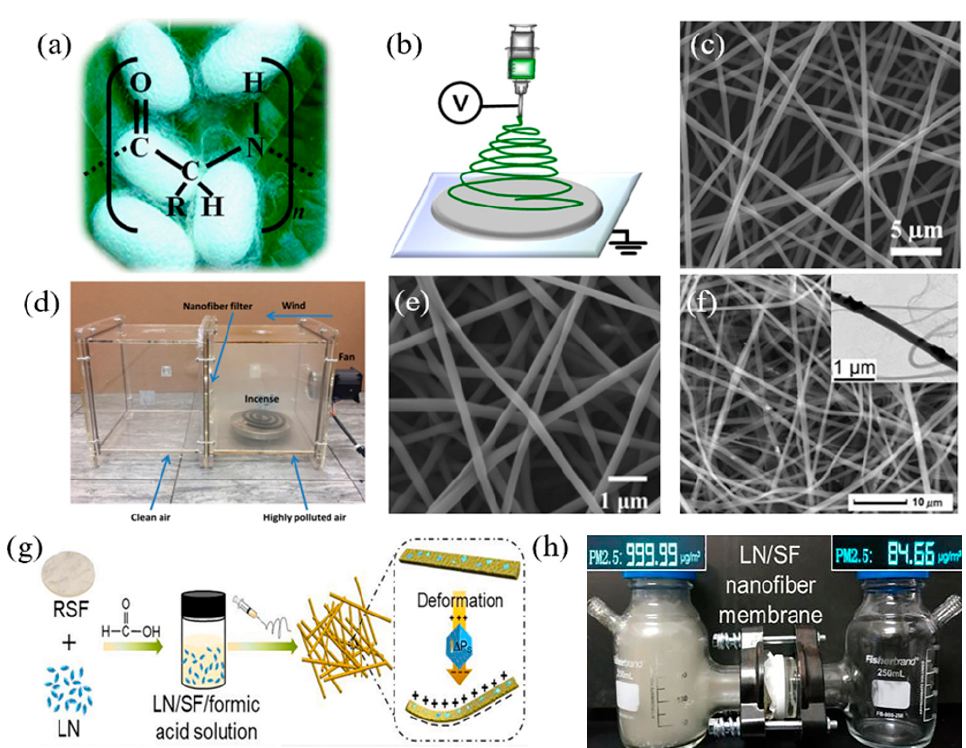
Figure 3. ( a ) Molecular formula of silk protein made from silkworm cocoons. ( b ) Schematic diagram of the preparation of SF nanofibers by electrostatic spinning. ( c ) SEM image of SF nanofibers [82]. ( d ) Simulated filtration demonstration of SF/PVA composite electrostatic spun nanofiber filter set blocking PM contamination diffusion [83]. ( e ) SEM image of SF/PVA nanofiber filters with the diameter of around 240 nm. ( f ) SEM image of LN/SF nanofiber membranes. The inserted image shows the transmission electron microscopy image of LN/SF nanofiber. ( g ) Schematic diagram of the detectors simulating LN/SF nanofiber membranes